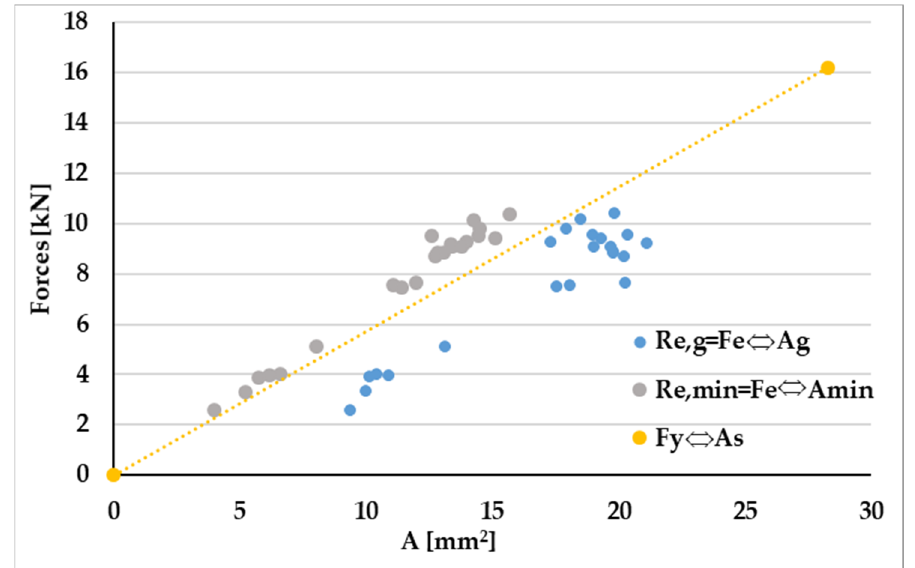
Figure 7. Dependence of the force F e on the yield strength R e related to the relevant area of the cross- section ϕ 6 (to minimum area A min and to the area determined from the weight loss A g ).